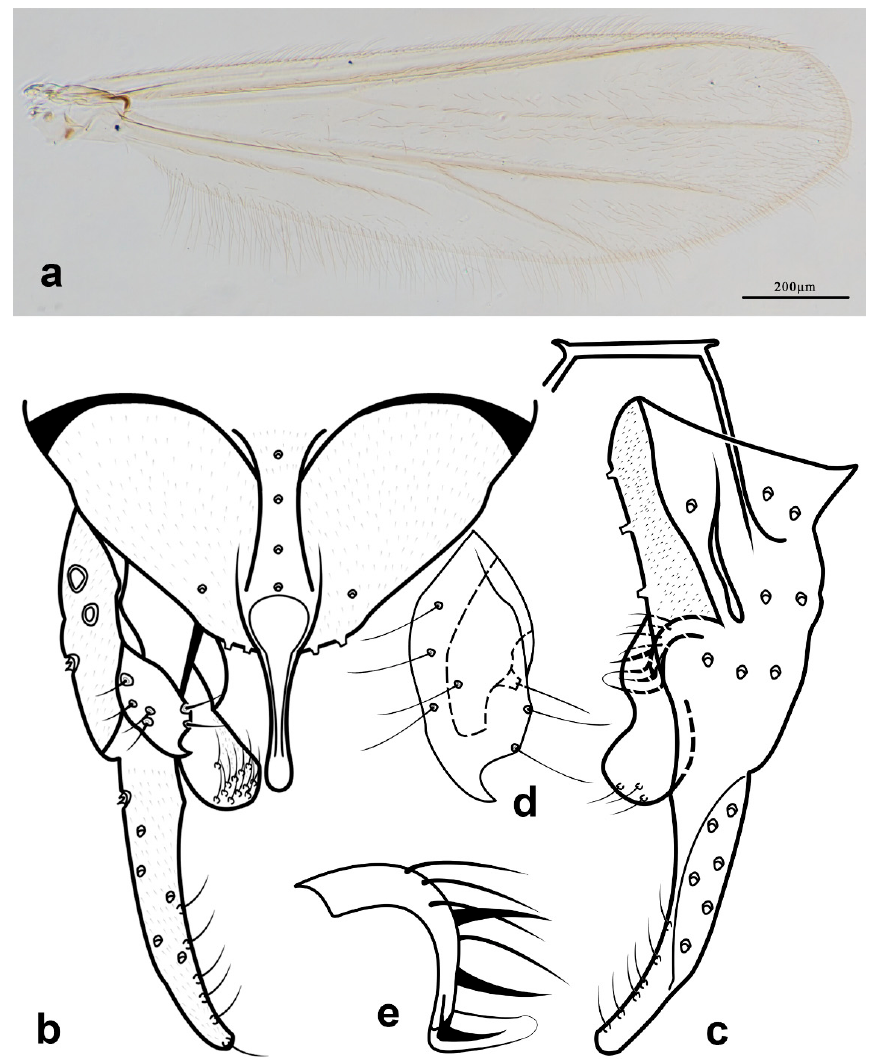
Figure 4. Rheotanytarsus ferringtoni sp. n. : ( a ) wing; ( b ) hypopygium, dorsal view; ( c ) hypopygium, ventral view; ( d ) superior volsella; ( e ) median volsella.